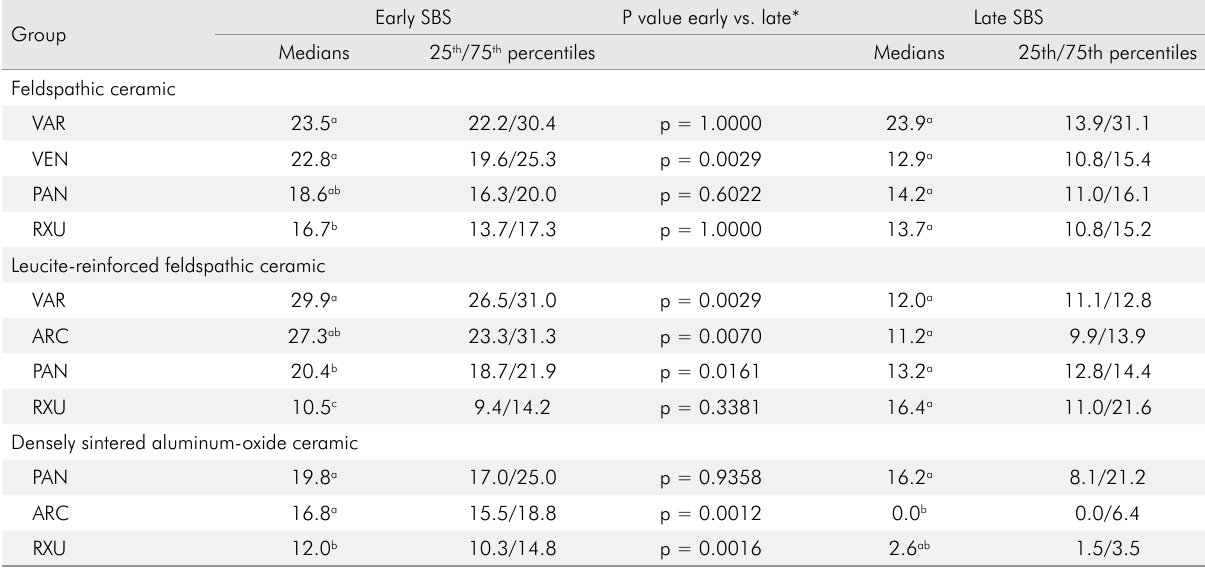
Table 2. Early and late shear bond strength (SBS) values (MPa).